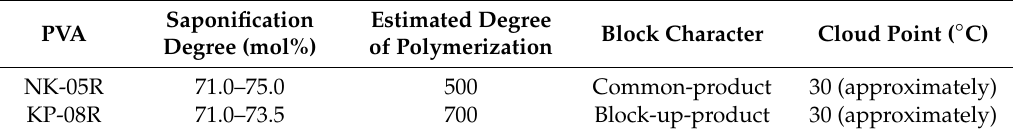
Table 1. Characteristics of the